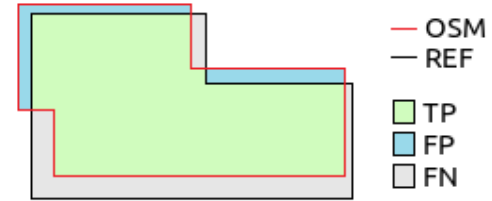
Figure 1. TP , FP and FN areas corresponding to OSM (red line) and REF (black line)